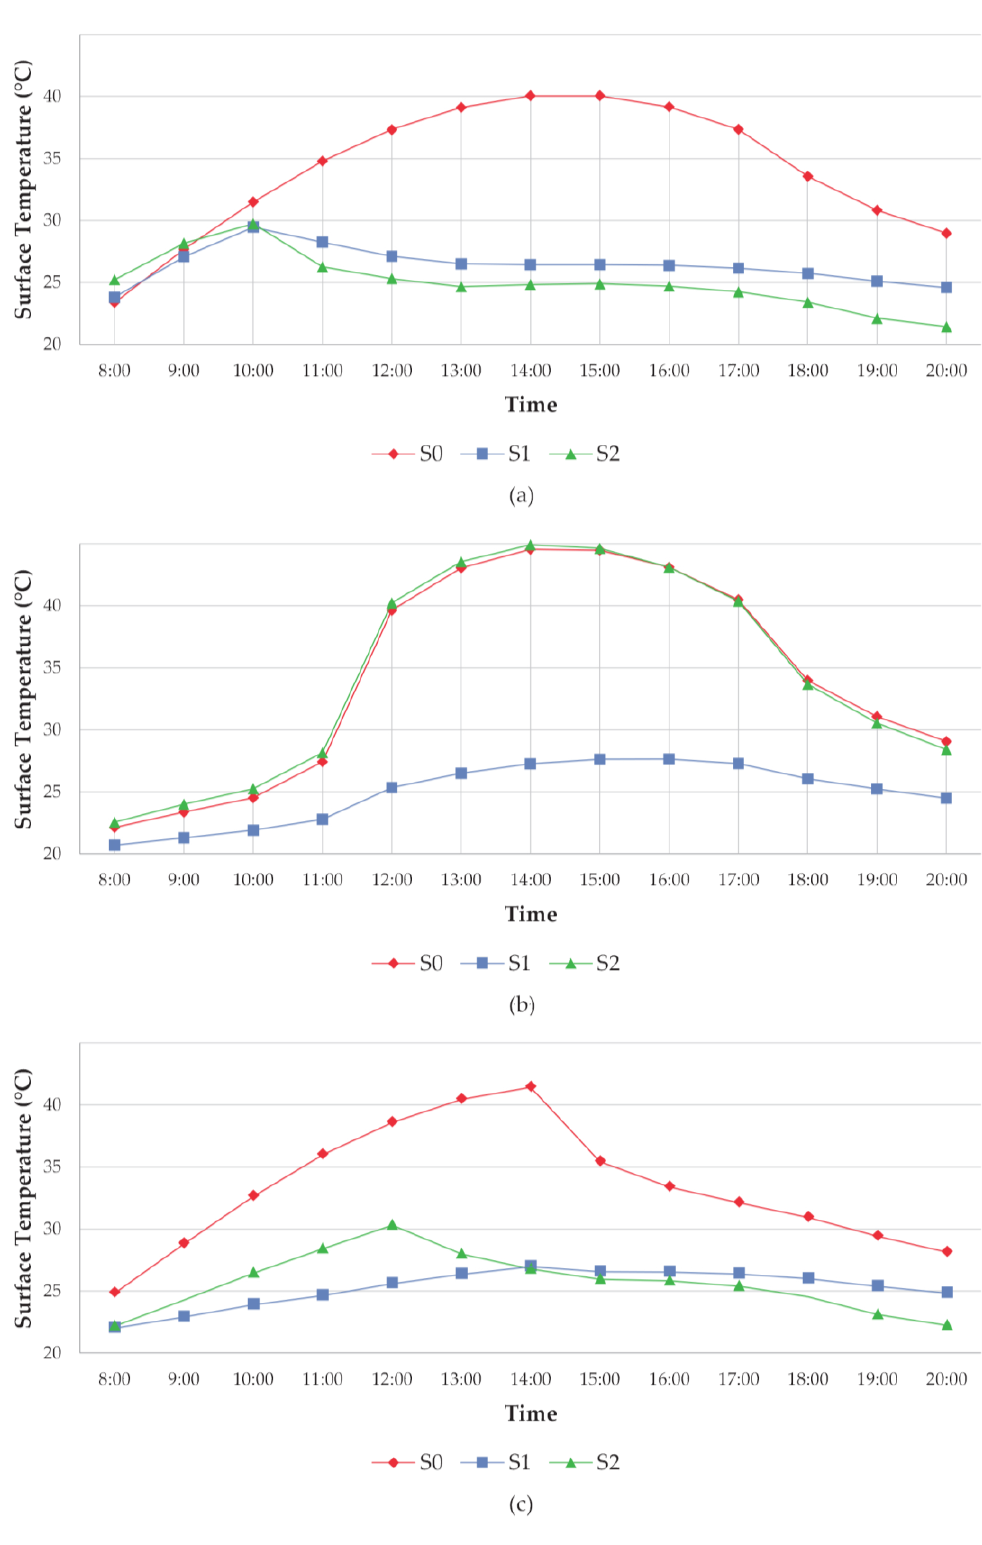
Figure 6. ( a ) Daily trend, on the 1st August 2014, of surface temperature ( T s ) in point A among the three scenarios: S0 (initial condition), S1 (cool pavements + trees) and S2 (cool roofs + cool walls + trees + grass); ( b ) daily trend of surface temperature ( T s ) in point B among the three scenarios: S0, S1, S2; ( c ) daily trend of surface temperature ( T s ) in point C among the three scenarios: S0, S1, S2.